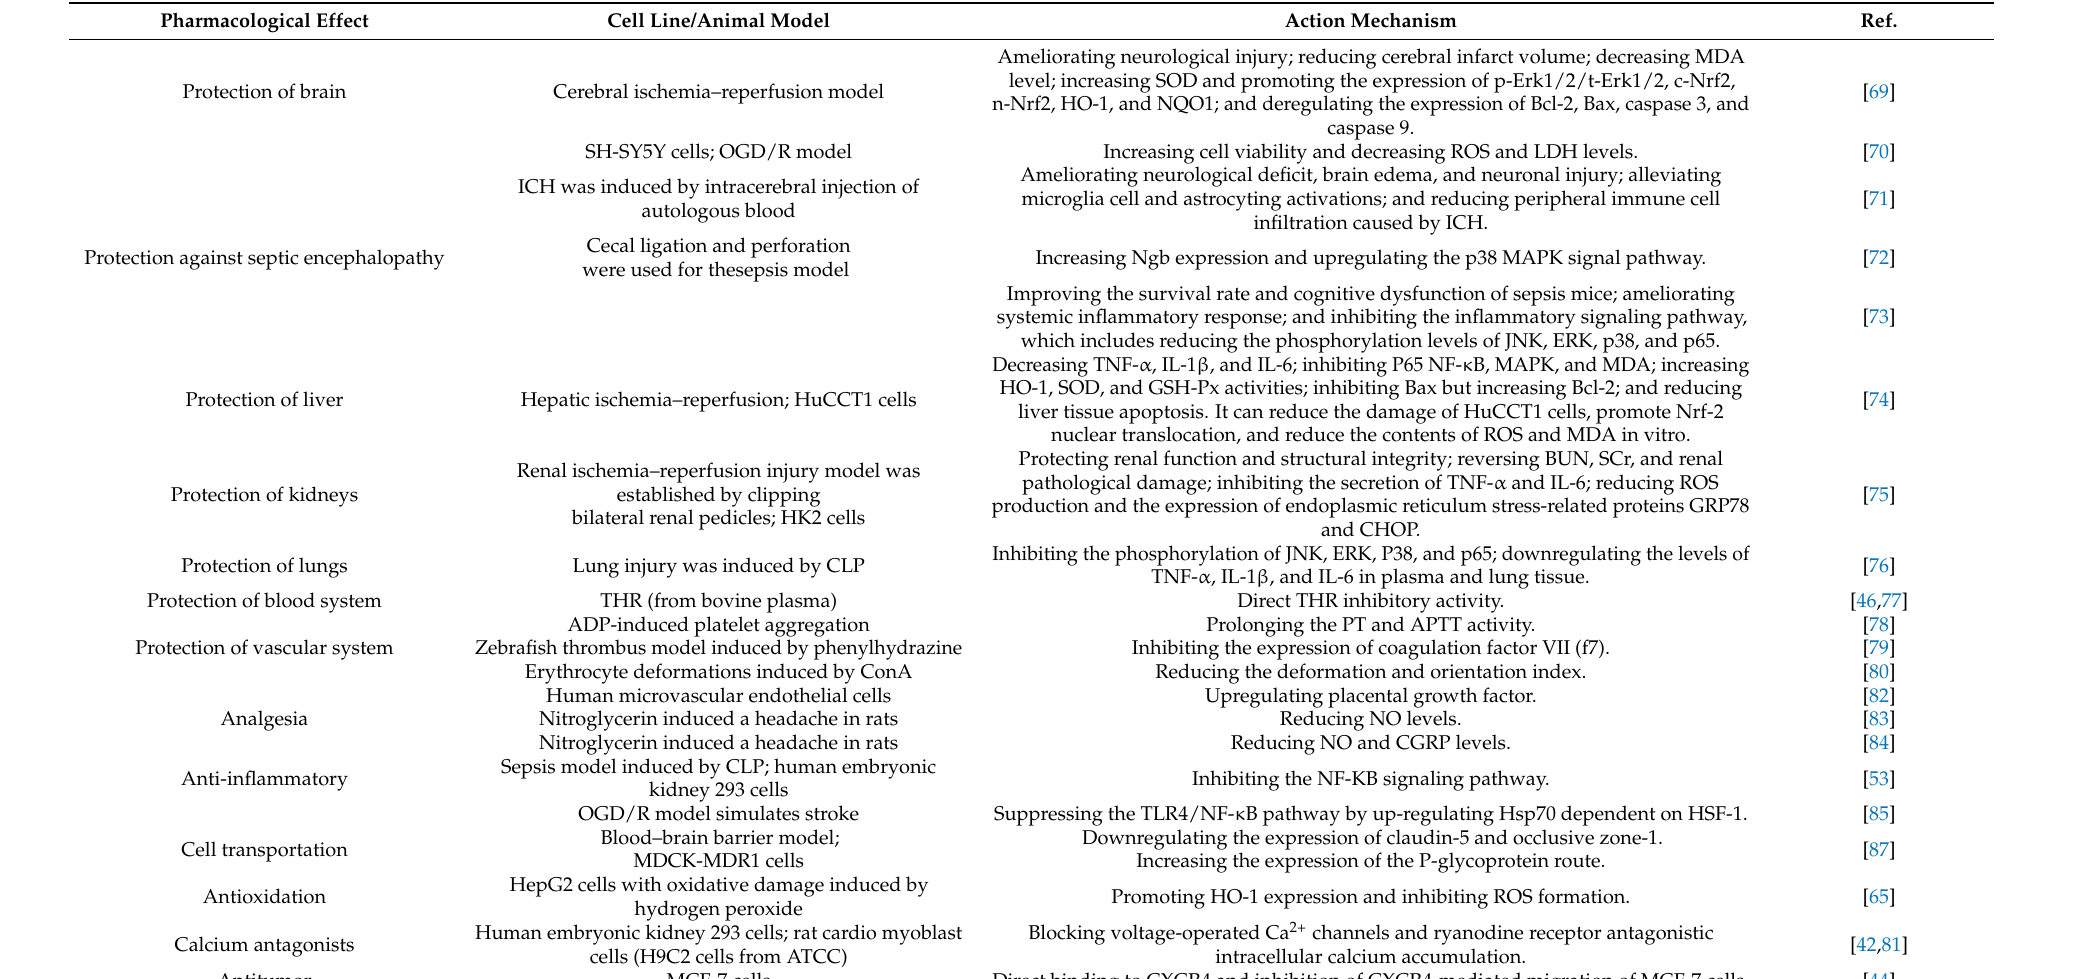
Table 5. The reported pharmacological effects of